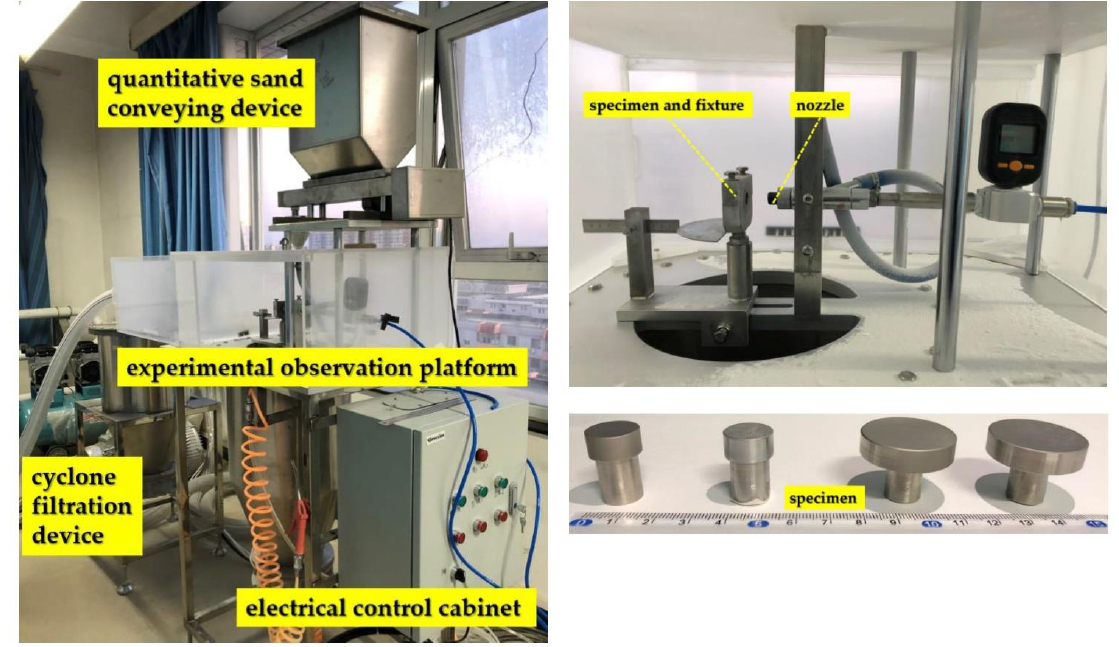
Figure 1. Partial diagram of the gas-solid two-phase flow erosion test device, nozzle, and specimen.